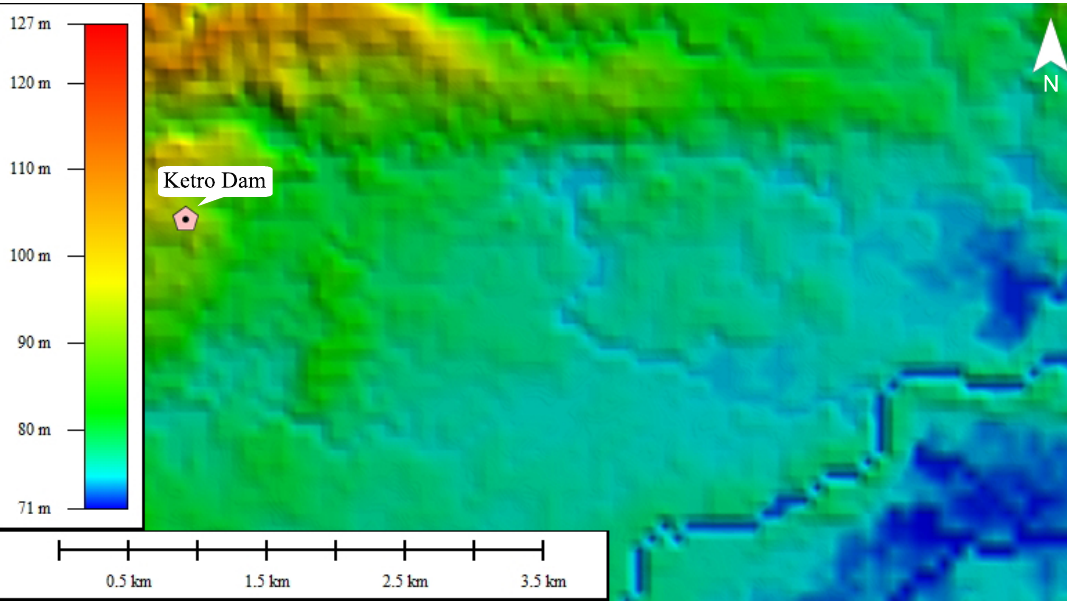
Figure 15. MERIT Hydro data for the downstream area of Ketro